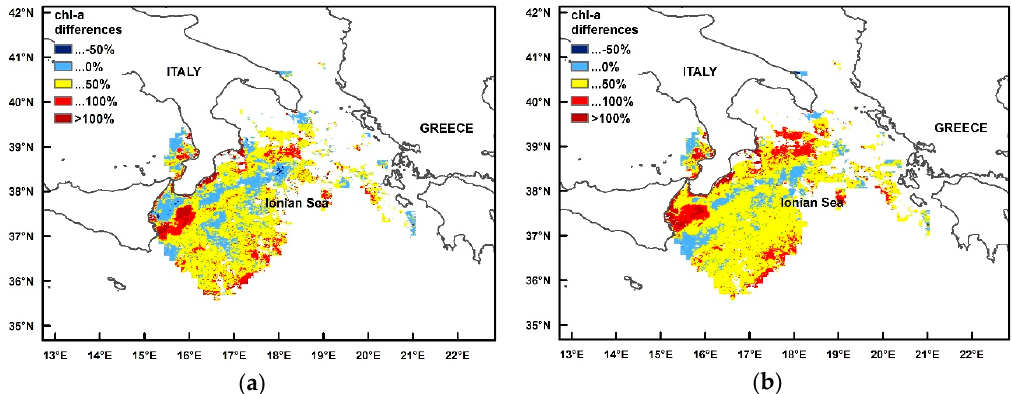
sum for 3–5 December 2008. J. Mar. Sci. Eng. 2019 , 7 , x FOR PEER REVIEW